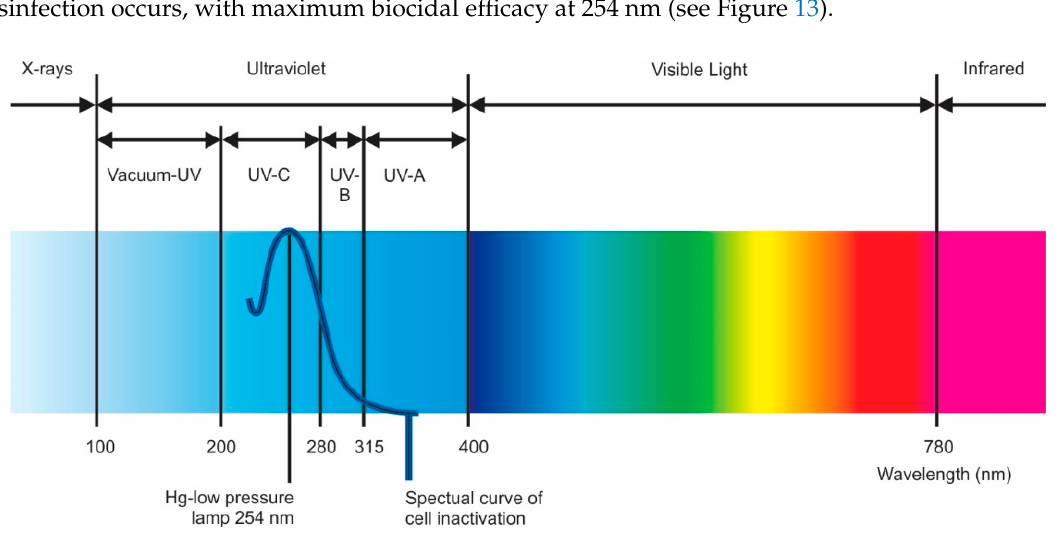
Figure 13. Electromagnetic spectrum with wavelength range for disinfection highlighted.